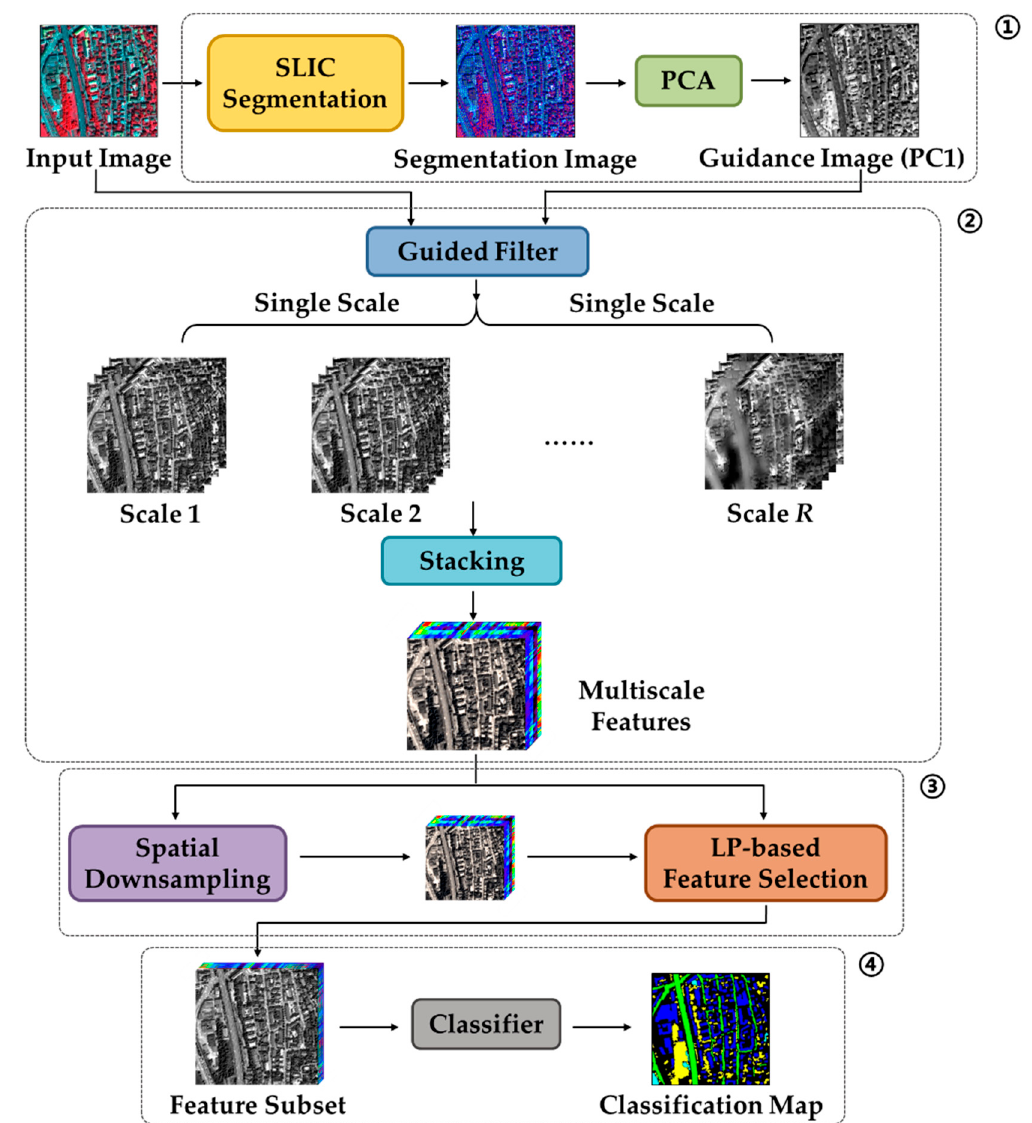
Figure 3. Block scheme of the proposed feature selection-based multi-scale superpixel guided filter (FS-MSGF) method for classification of the VHR remotely sensed imagery. LP, linear prediction.